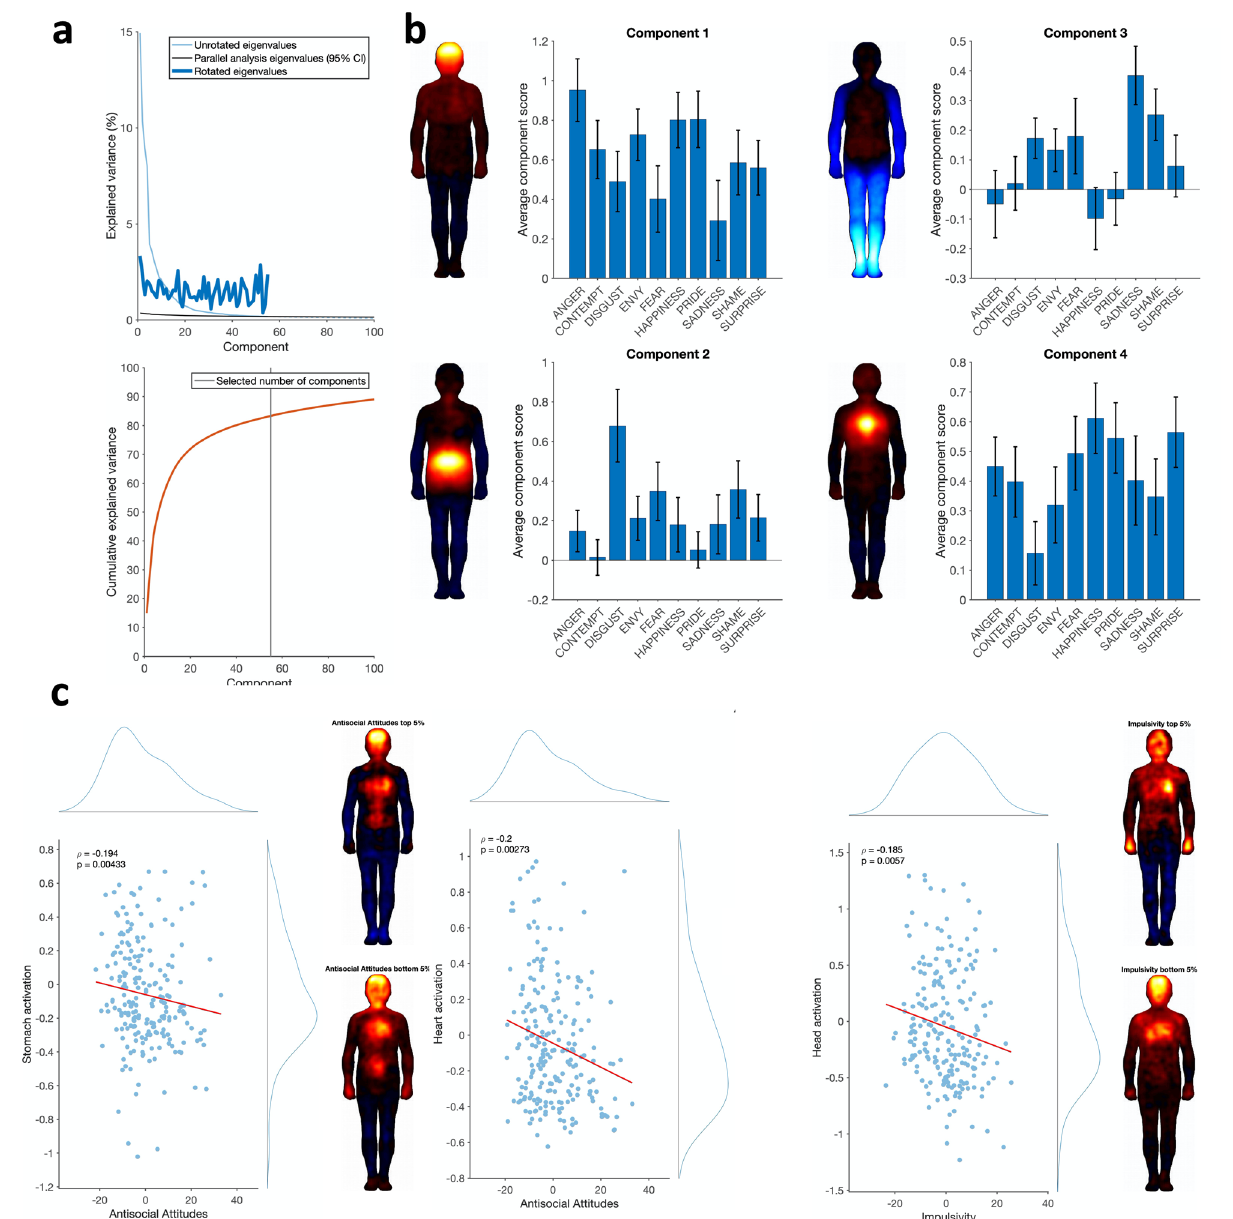
Figure 2. Results of the PCA of the body map data and correlation of BSM and personality PCA components. ( a ) Eigenvalue plot for the BSM PCA, as in Fig. 1a. ( b ) Loadings and averaged component scores for the top 4 components. Silhouette plots show the loadings of the rotated component. Bar plots show the scores of the component, averaged over subjects within each emotion; error bars indicate standard error. These bars indicate the magnitude at which the component is activated in each emotion. ( c ) Correlation analysis of body map and personality PCA components. Spearman’s ρ and its corresponding p value are indicated. Histograms show the distribution of each variable. Silhouette plots show averaged BSMs from the extremes of the personality distribution (top and bottom 5% of each personality PCA component), averaged across